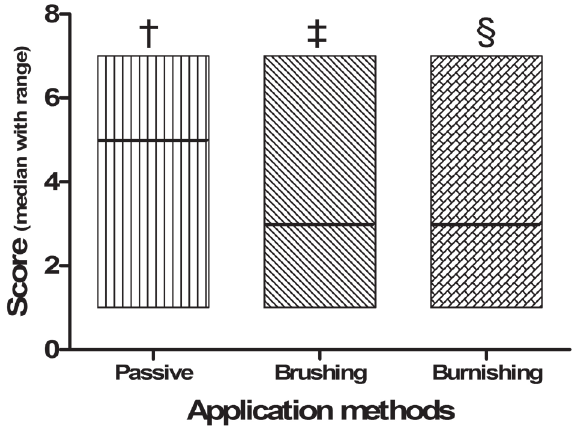
Figure 6- Median with range of the scores obtained for the three application periods of the sodium citrate. Application periods with the same symbol are not statistically